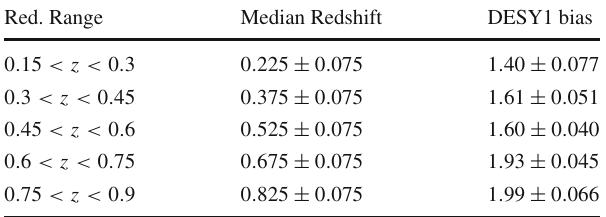
Table 1 The measured bias data of the 1-year DES LRGs from [23] Red.